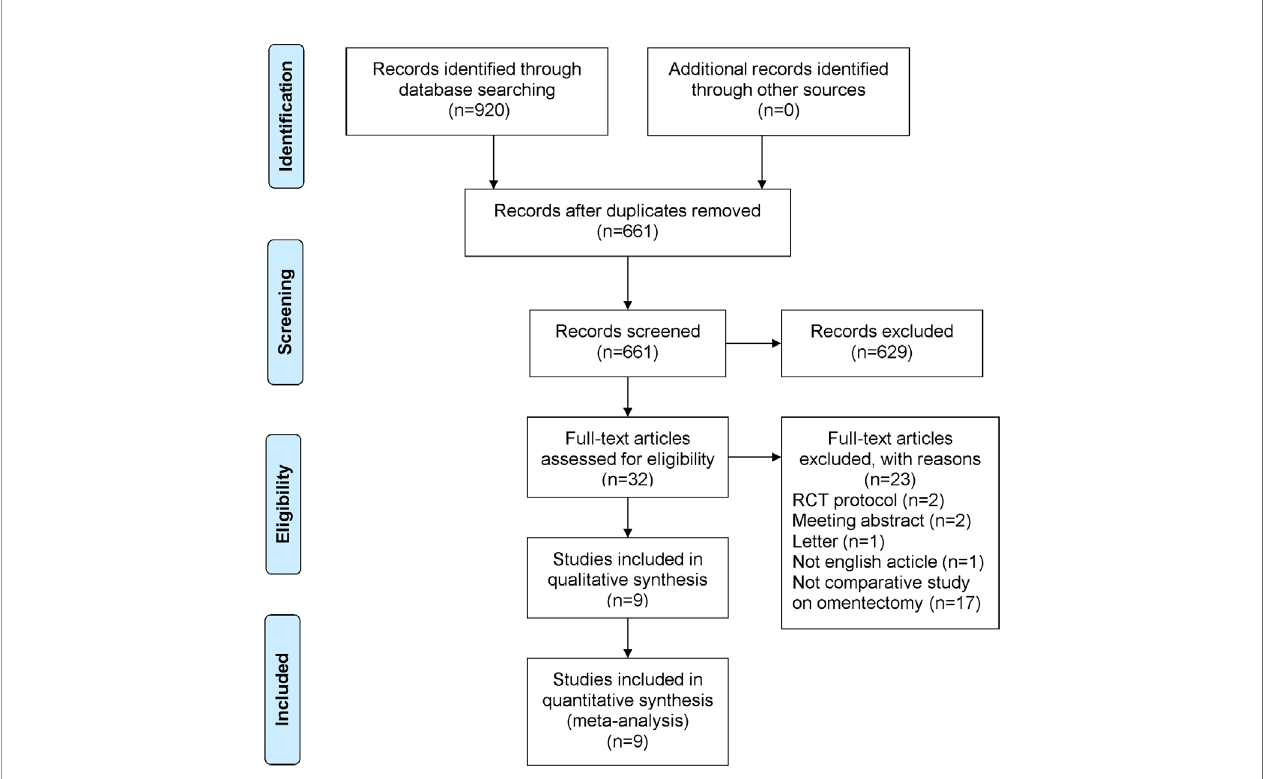
TABLE 1 | Characteristics of included studies. Reference Country Study